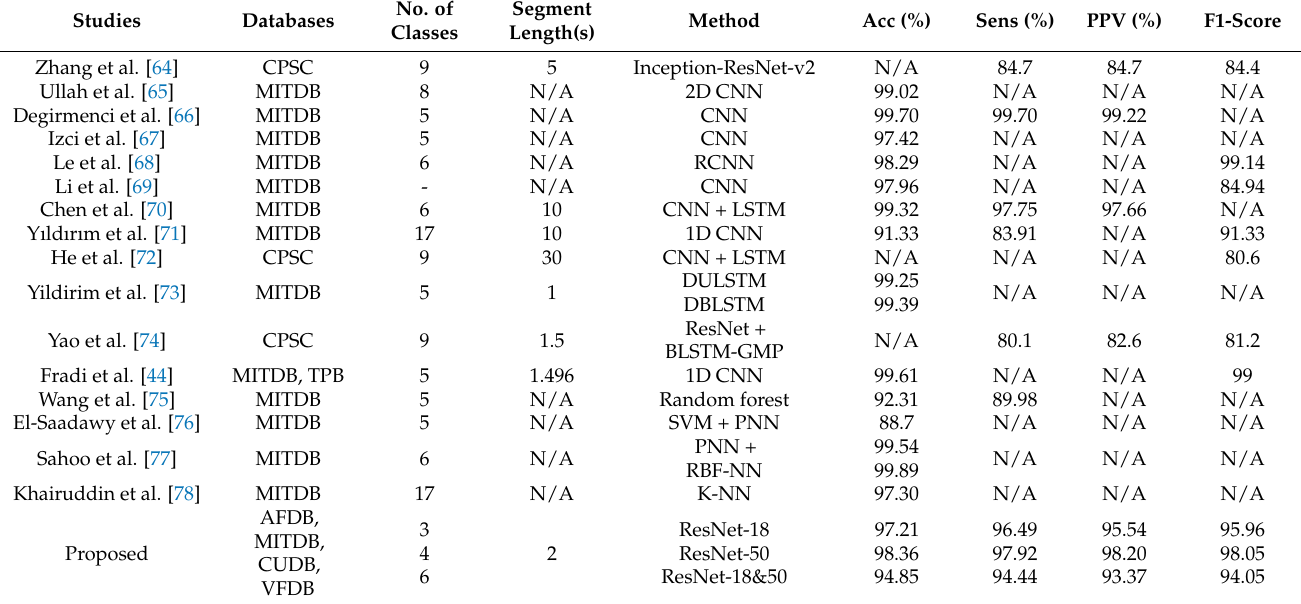
Table 16. ECG arrhythmia classification